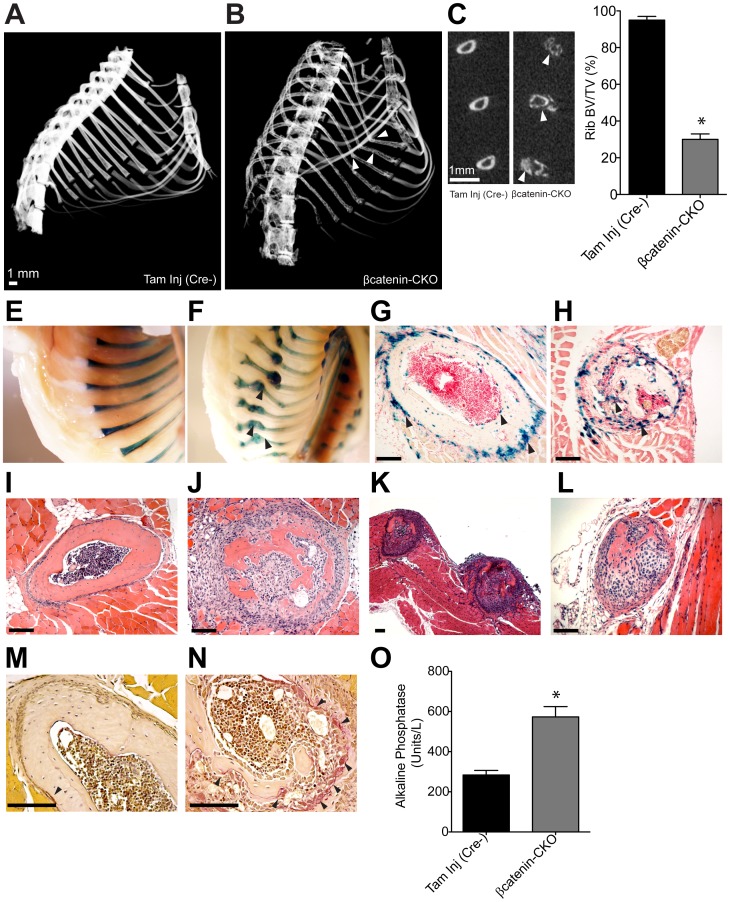
βcatenin-CKO mice exhibit extensive rib resorption from osteoclastogenesis.(A–C) Micro CT of the thoracic cage of (A) control and (B) βcatenin-CKO animals. White arrowheads point to osteopenia and rib deformity. (C) Ribs shown in coronal plane with bone destruction (arrowheads) with (D) Rib bone volume/total volume, BV/TV) (mean±S.E.M.; n = 6 animals/group, *p<0.0001, BV/TV measurements were made on cortical rib) (E,F) Xgal staining in-situ of rib cage of (E) Col1a2CreERT and (F) βcatenin-CKO lineage reporter animals with callus and fracture deformities (black arrowheads). (G,H) Xgal staining of rib sections of (G) Col1a2CreERT and (H) βcatenin-CKO lineage reporter animals (arrowheads point to Cre expressing cells in blue) (I–L) Hematoxylin-eosin staining of rib sections of (I) control and (J–L) βcatenin-CKO animal showing (J) gross rib destruction with cellular infiltrate (K) involvement of consecutive ribs (L) complete rib resorption (M,N) TRAP staining of rib sections with TRAP positive cells (arrowheads) in (M) control and (N) βcatenin-CKO animals (O) Plasma alkaline phosphatase (mean±S.E.M., n = 10 animals/group, *p<0.05). All measurements and staining were done in animals 10 days post completion of tamoxifen. (Scale bar: 100 µm).